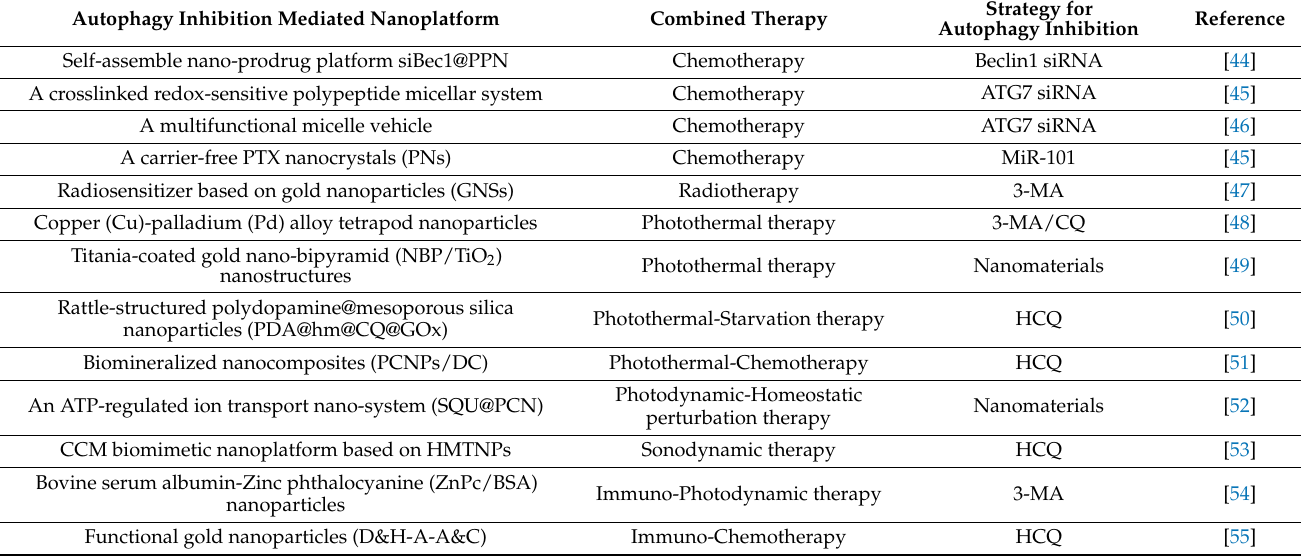
Table 1. Summary of combinatorial therapy based on nanotechnological platforms-mediated comple- mentary autophagy